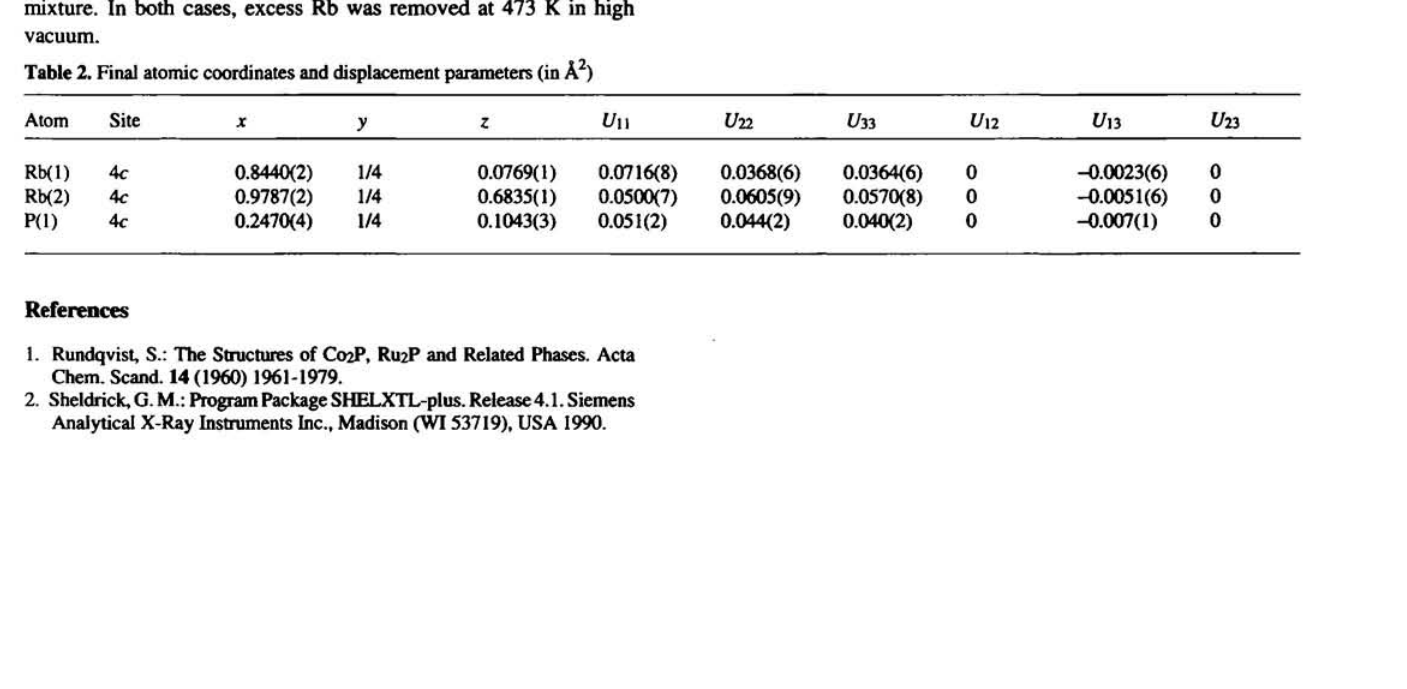
Table 2. Final atomic coordinates and displacement parameters (in Ä 2 )